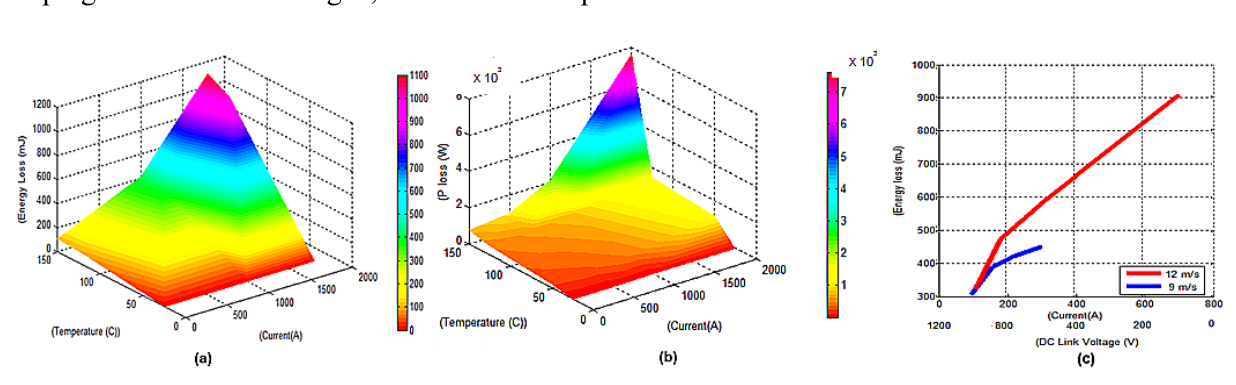
Figure 7. ( a ) Insulated gate bipolar transistor (IGBT) switching-on energy losses; ( b ) Conduction losses; ( c ) DC link voltage vs. current vs. on time